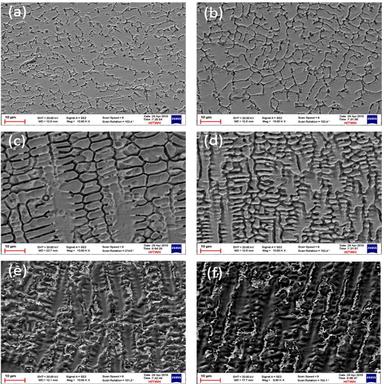
The microstructure of FGM with different compositions: (a) 100%316L + 0%Inconel625; (b) 80%316L + 20%Inconel625; (c) 60%316L + 40%Inconel625; (d) 40%316L + 60%Inconel625; (e) 80%316L + 20%Inconel625; (f) 0%316L + 100%Inconel625.